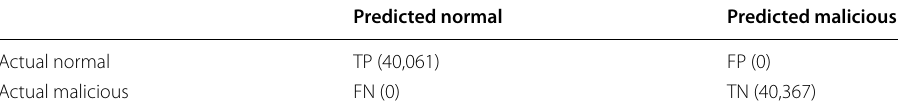
Table 12 Confusion matrix of DTREE